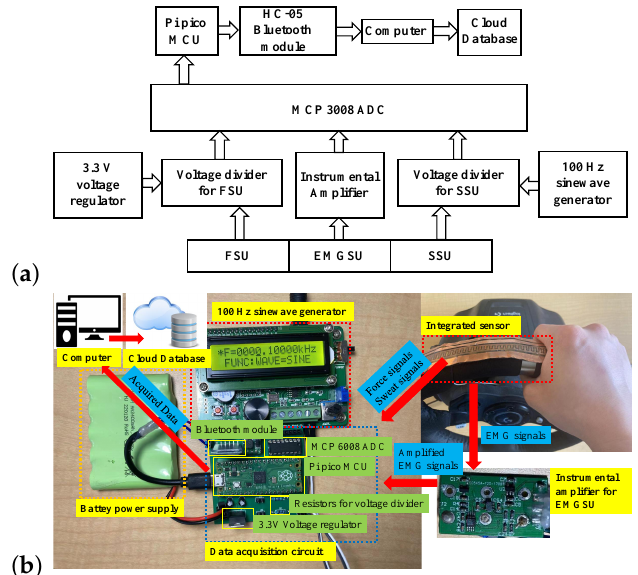
Figure 2. The measurement system for the integrated sensor: ( a ) diagram of the measurement system; and ( b ) the prototype of the measurement